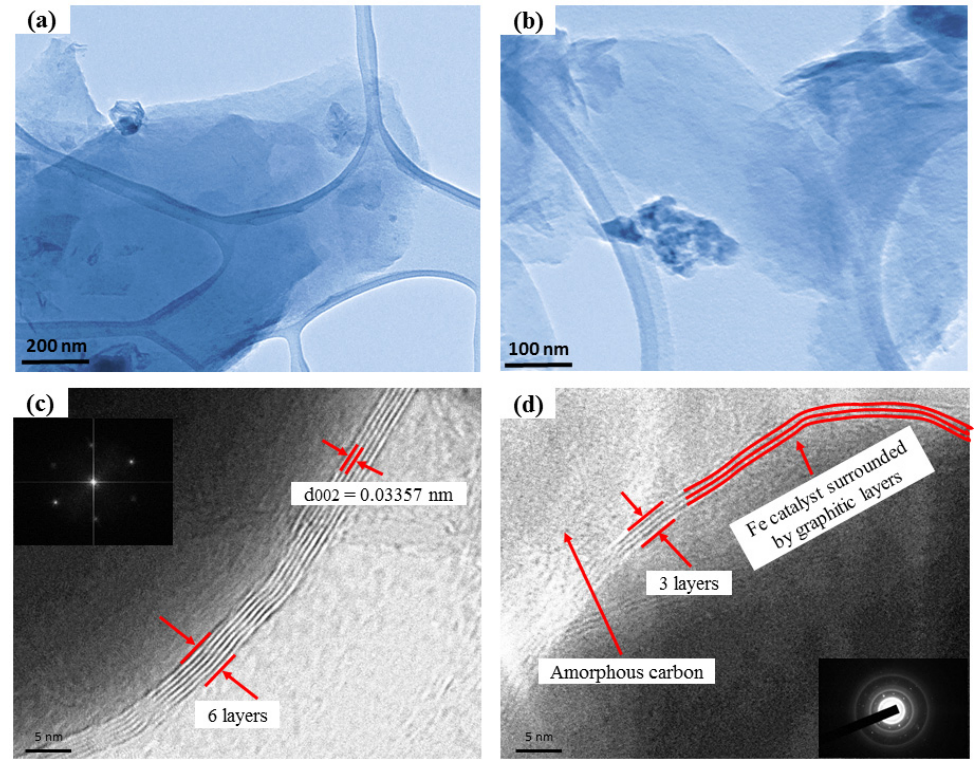
Figure 4. ( a , b ) TEM images of S10% Fe sample at different magnifications, ( c , d ) High-resolution transmission electron microscopy images of S10% Fe few-layer graphene sample. In addition, the inset ( c ) represents the FFT pattern with a hexagonal crystal structure, and the inset ( d ) shows the SAED configurations.